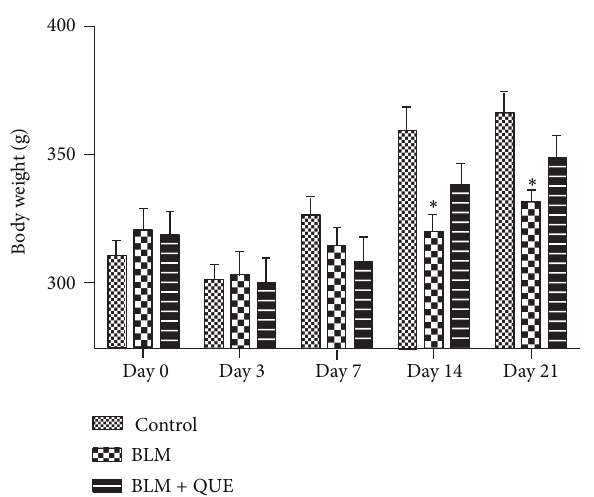
Figure 1: Effect of quercetin (QUE) on body weight of bleomycin- (BLM-) treated rats. 𝑛 = 10 . ∗ 𝑃 < 0.05 versus control group.